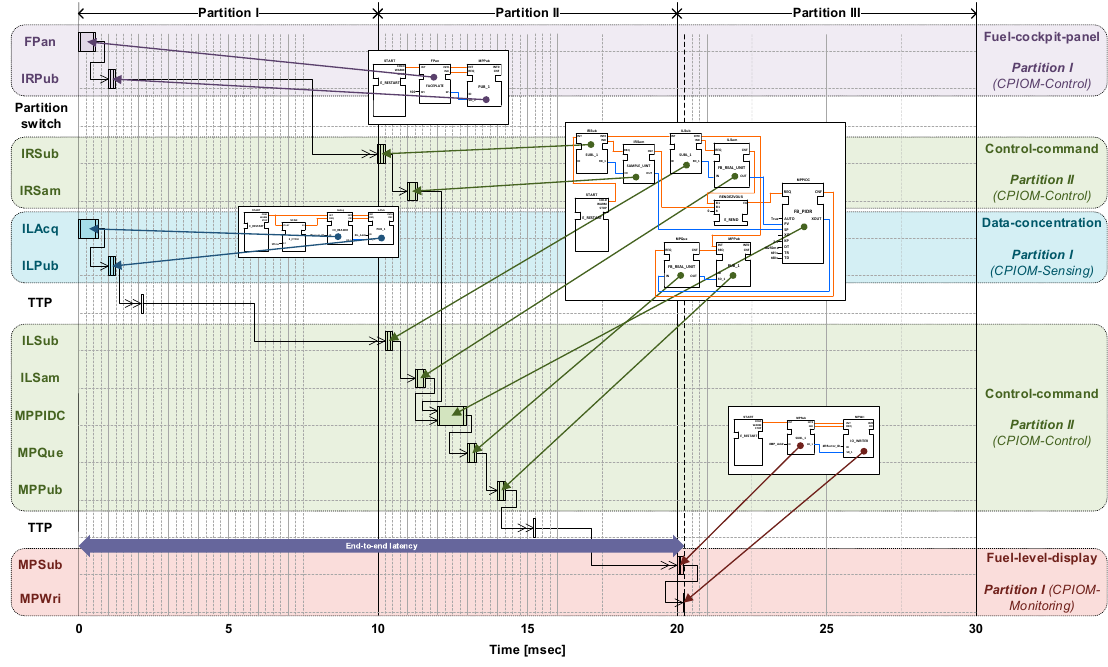
Figure 17. Scheduling strategy 2a of the FBs for the ITT control.